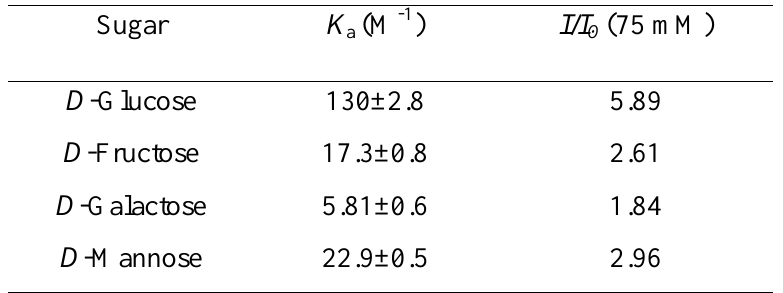
) of 2 with four saccharides and the corresponding maximal a ) at 420 0